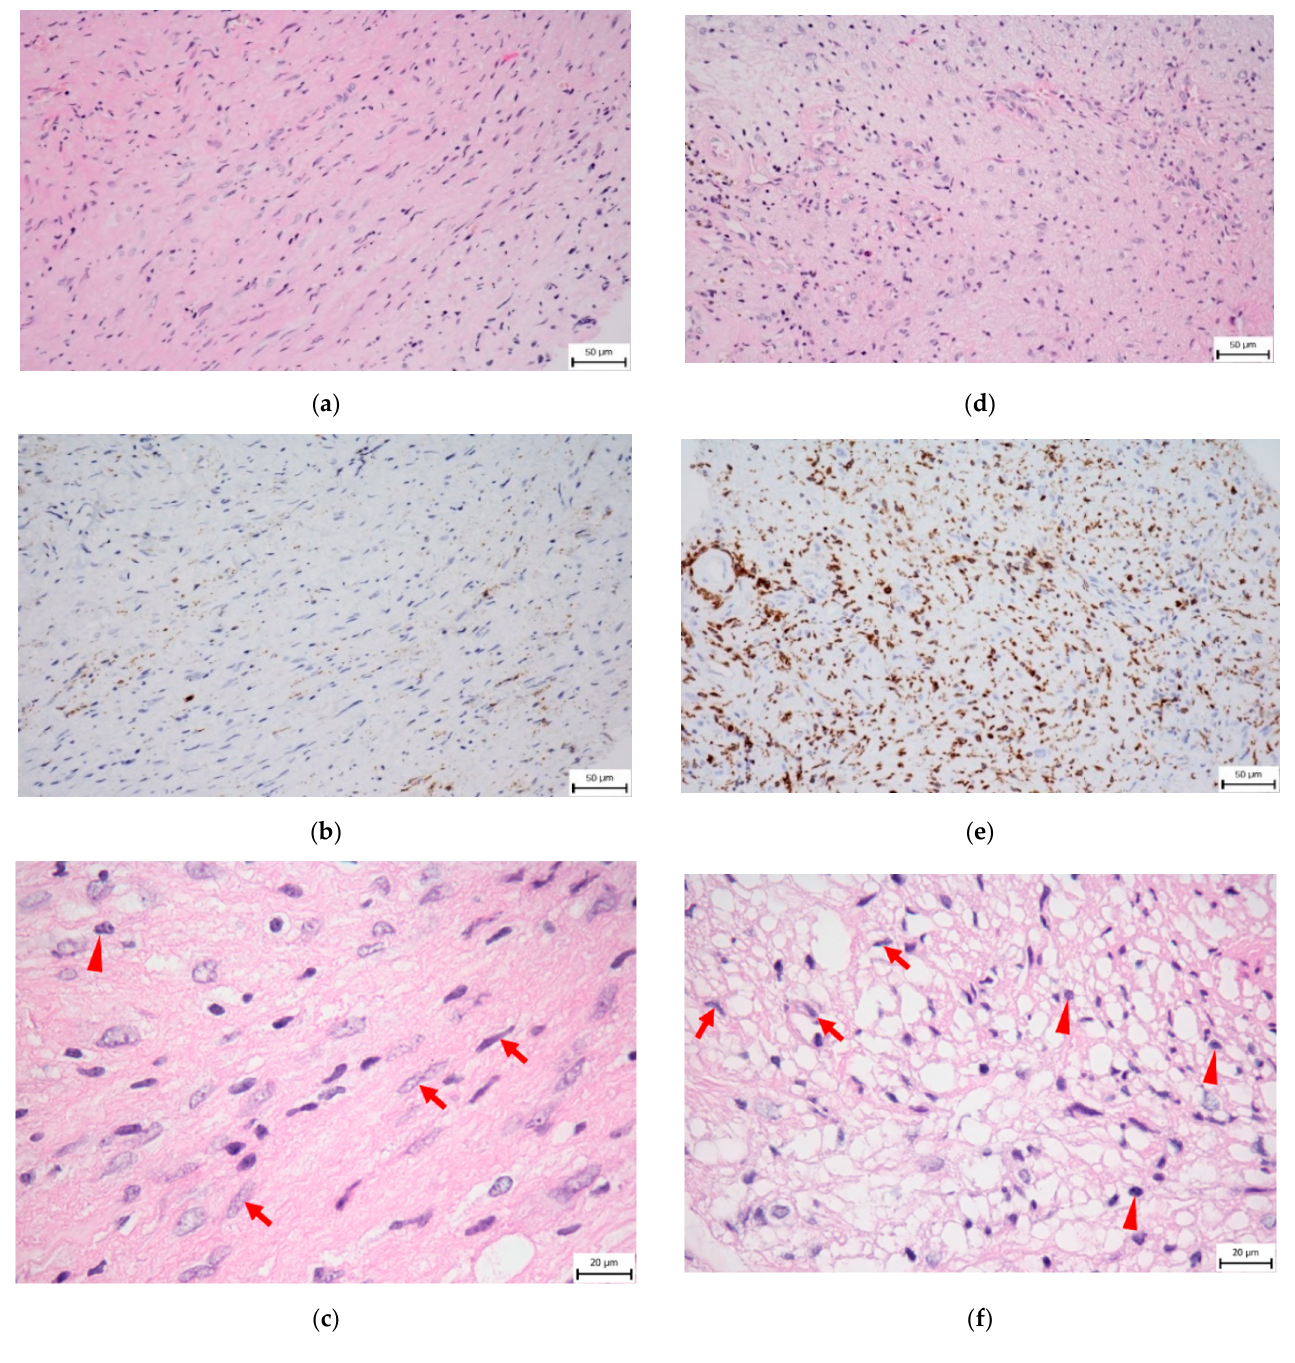
Figure 2. Histology of VS, sections from the same tumor. Arrows show tumor cell nuclei; triangles point to macrophage nuclei. ( a ) Hematoxylin–eosin staining of tumor cell-rich Antoni A area (400 × magnification). High density of tumor cells, presence of elongated cell nuclei. ( b ) CD163 immunohistochemical staining of Antoni A area (400 × magnification), low CD163 + macrophage density (brown). ( c ) Hematoxylin–eosin staining-Antoni A area (1000 × magnification). ( d ) Hematoxylin–eosin staining of Antoni B area (400 × magnification). The disorganization of cellular arrangement, presence of microcystic pattern, and different shapes of cell nuclei. The stroma is loose. Immune cells are abun- dant. ( e ) CD163 immunohistochemical staining of Antoni B area (400 × magnification), high CD163 + macrophage density (brown). ( f ) Hematoxylin–eosin staining-Antoni B area (1000 × magnification). Bar is 50 µ m ( a , b , d , e ) and 20 µ m ( c , f ). This figure was provided by the Department of Pathology